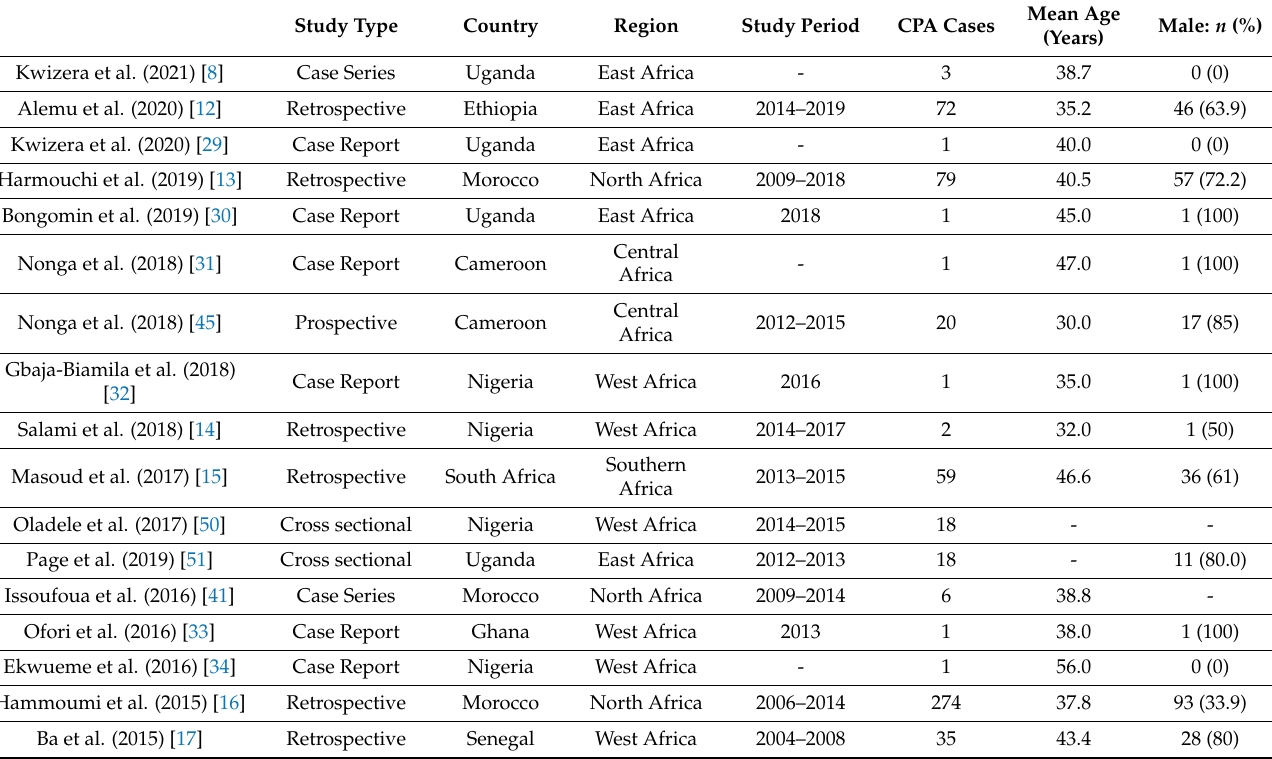
Table 2. Characteristics of studies